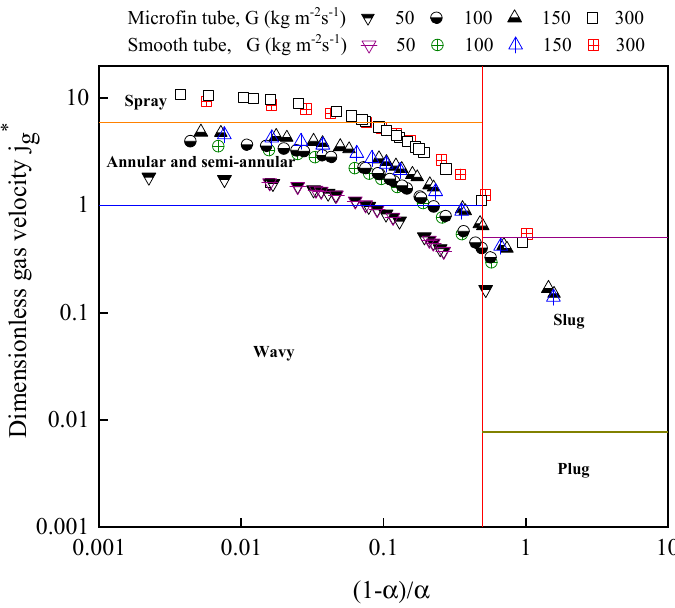
Figure 10. Flow pattern prediction by Tandon flow pattern map [29].